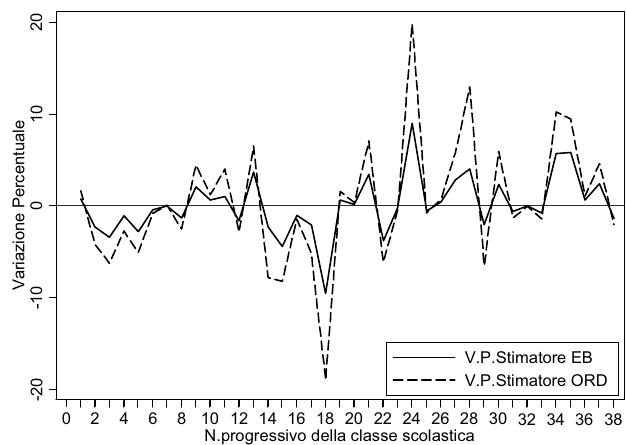
Figura 2 – Variazione percentuale per classe scolastica dei valori delle stime dell’intercetta ha passando dal modello MIC -0 (senza variabili individuali) al modello MIC -3 (con tre variabili individuali) per lo stimatore ordinario ORD